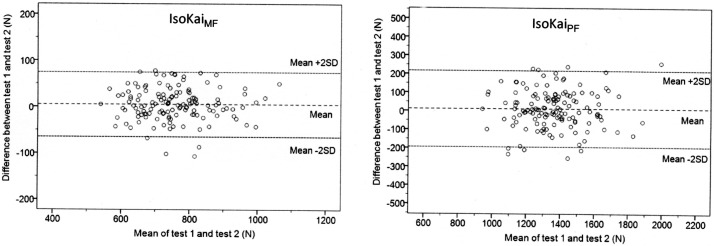
The mean of test 1 force (rater 1) and test 2 force (rater 2) plotted against the difference between test 1 force (rater 1) and test 2 force (rater 2) in the interrater sample.IsoKaiMF, IsoKai mean force (N); IsoKaiPF, IsoKai peak force (N); LOA, limits of agreement.